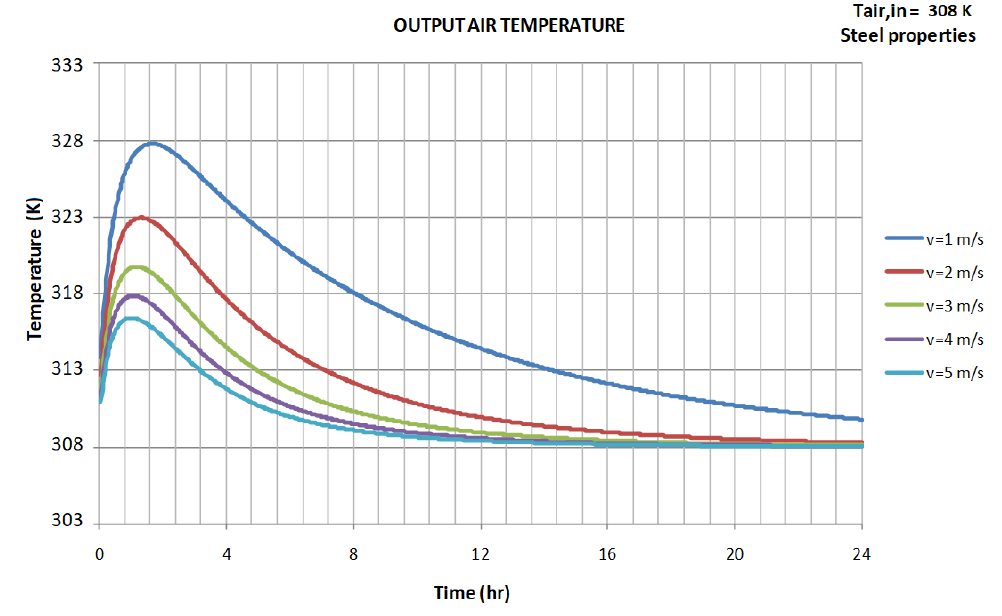
Figure 6. Output air temperature (steel properties).